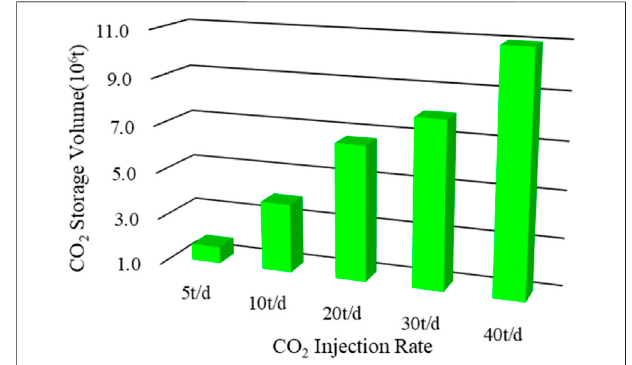
FIGURE 8 | CO 2 storage volume under different injection